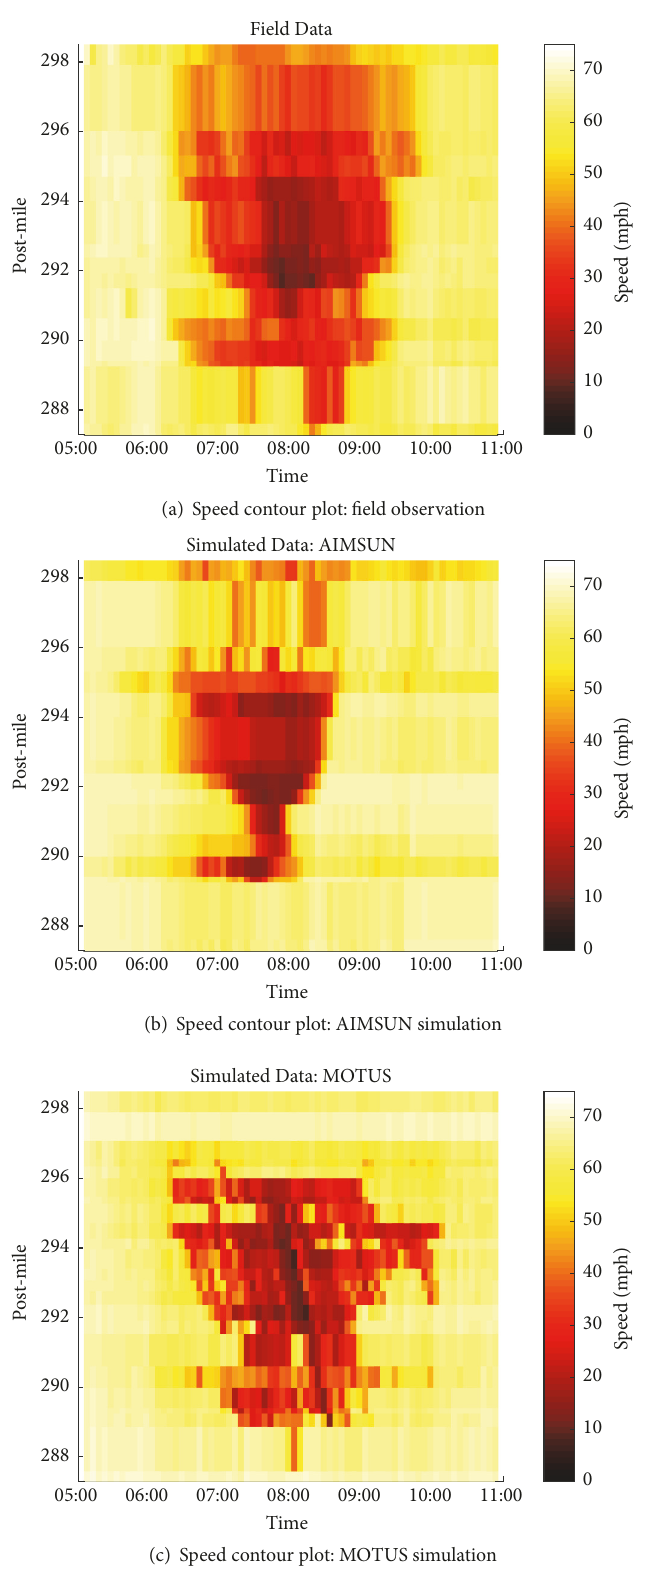
(c) Speed contour plot: MOTUS simulation Figure 5: Comparison of speed contour